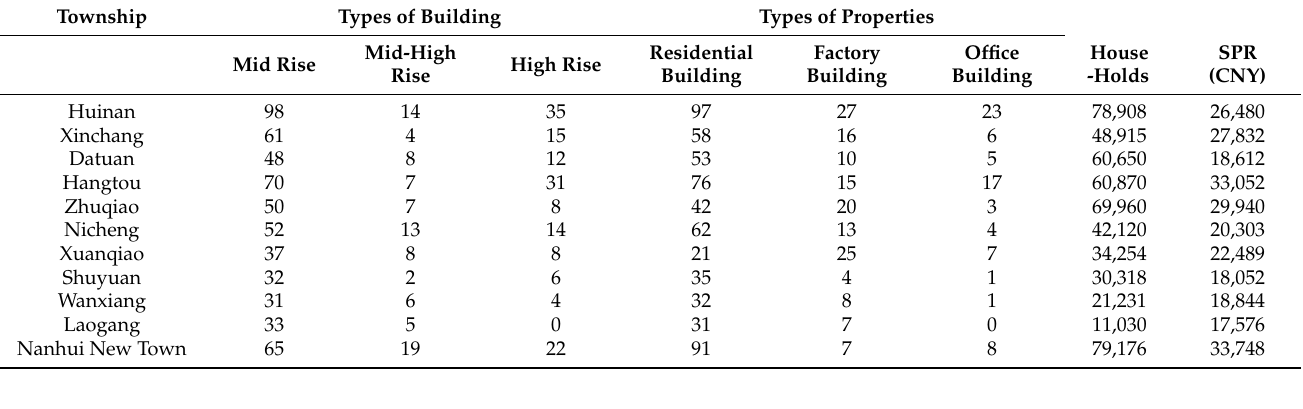
Table 1. Statistical results of the “PDIA-SL” dataset.